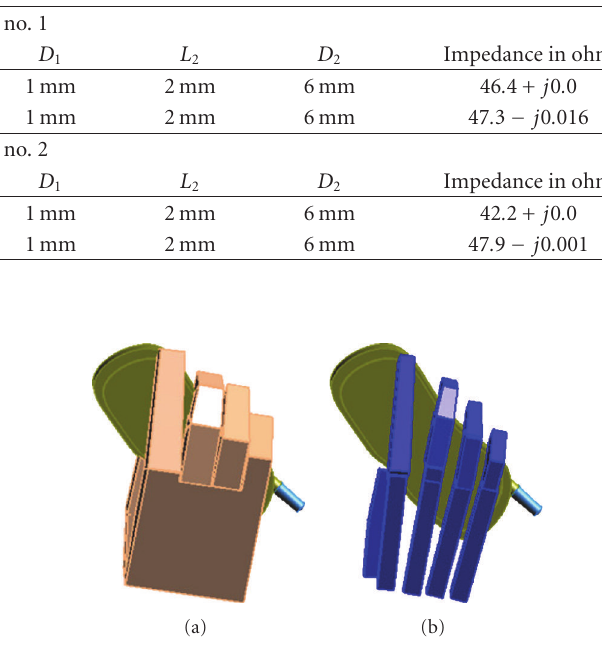
Figure 5: The CAD representation of the proposed semirealistic hand model holding the proposed handset; (a) all hand tissues, (b) hand-bones